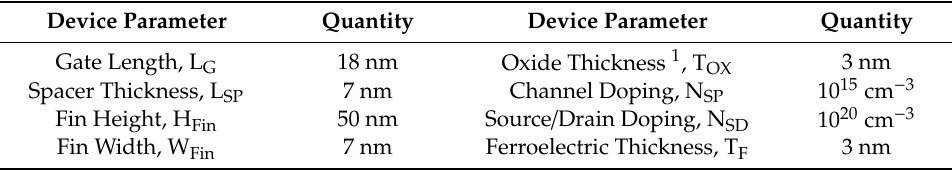
Figure 3. ( a ) Estimated current-vs.-voltage ( I D -vs.- V G ) of baseline FinFET in log (left) and linear (right) scale. ( b ) Estimated capacitance-vs.-voltage ( C G -vs.- V G ) of baseline FinFET. Table 1. The important device parameters for MFMIS NC FinFET.